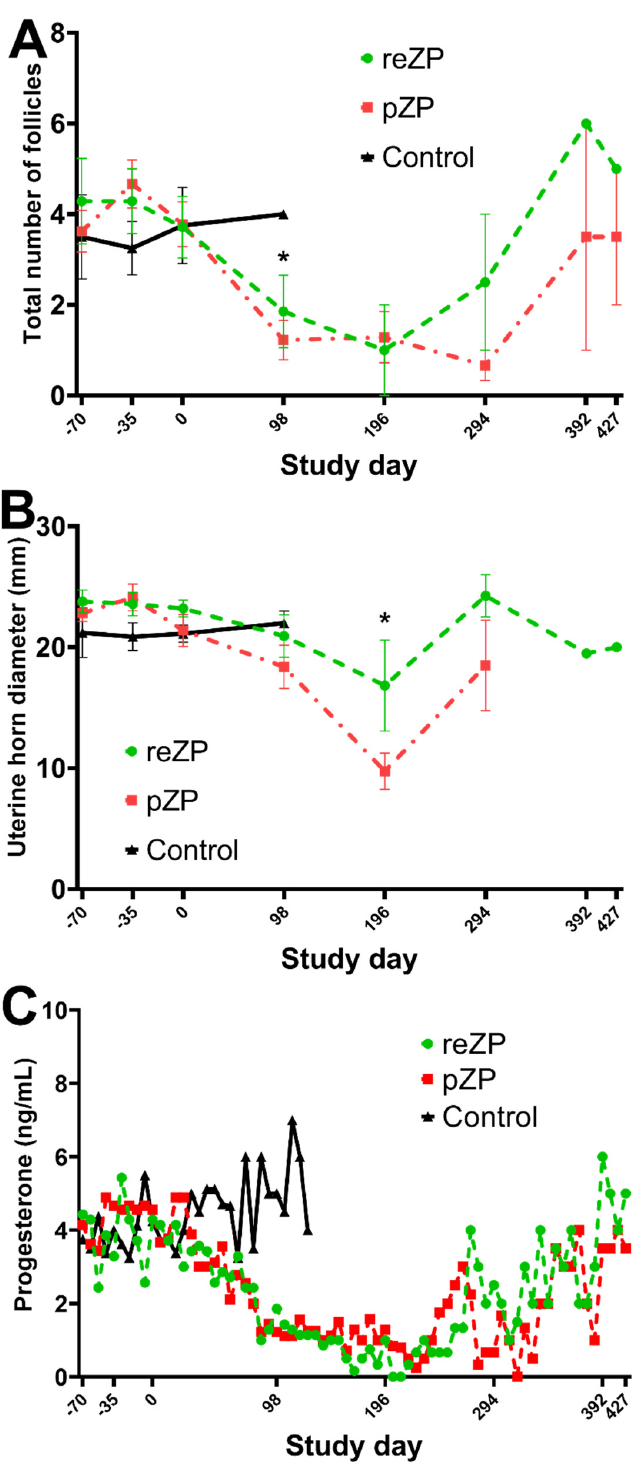
Figure 2. Total mean follicle counts (( A ); ± SEM), uterine horn diameter (( B ); ± SEM) and progesterone concentration (( C ); mean only) of jennies vaccinated with recombinant zona pellucida vaccine (reZP), porcine native zona pellucida (pZP), or placebo (Control) from Day − 70 to the day of pregnancy diagnosis. Jennies were vaccinated with three doses of reZP on Days − 70, − 35 and 0. For both pZP and Control, the primary dose and the booster were administered on Days − 35 and 0. V1, primary vaccination; V2, 1st booster vaccination; V3, 2nd booster vaccination). Asterisk (*) denotes effect of time (Day − 70; p < 0.05).